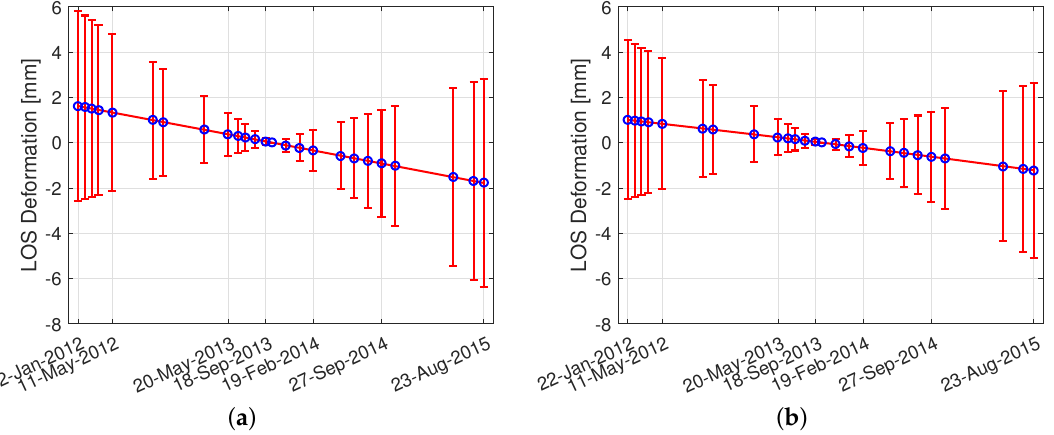
Figure 12. Scatterplot with std bars of retrieved deformation rates for ( a ) StaMPS and ( b )